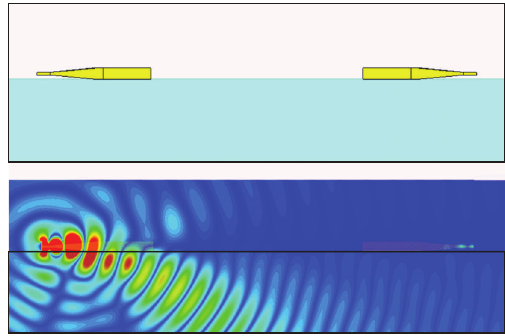
Figure 8: Optical wireless link between nanoantennas on glass substrate and corresponding radiated E-field. Distance between nanoantennas is 4 µ m; frequency is 300